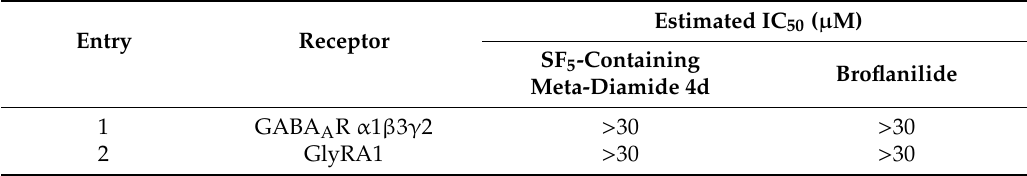
Table 2. Summary of the antagonist activities of SF 5 -containing meta-diamide insecticide 4d according to ion channel cell-based ionflux assays of wild-type GABA A Rs and